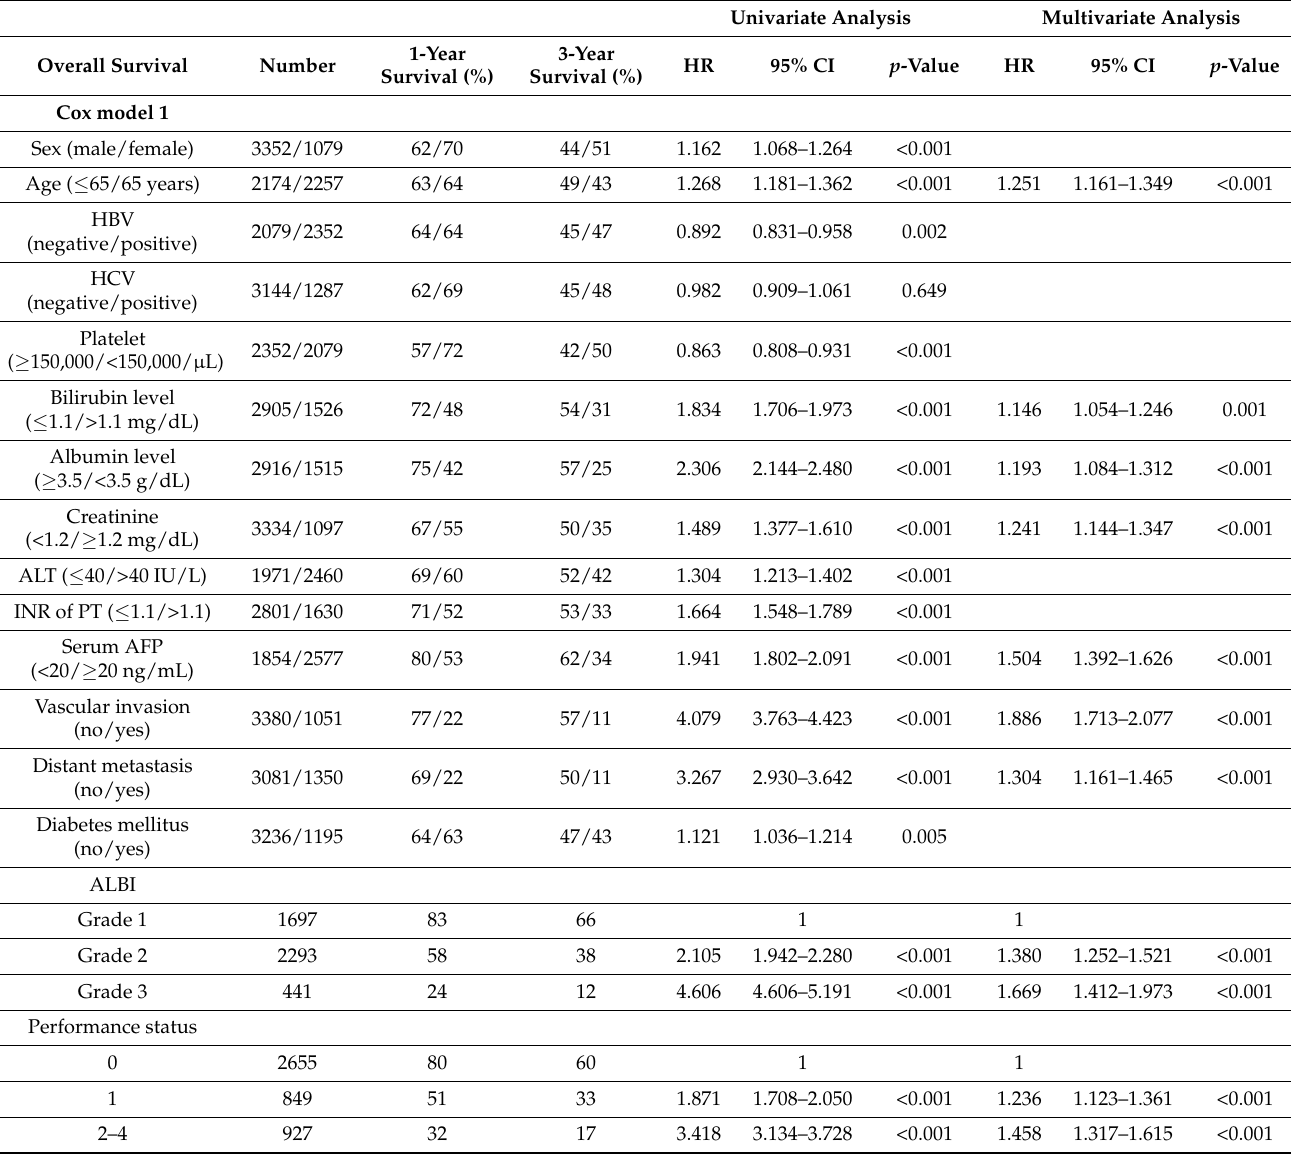
Table 2. Univariate and multivariate survival analyses of patients with HCC ( n = 4431). Univariate Analysis Multivariate